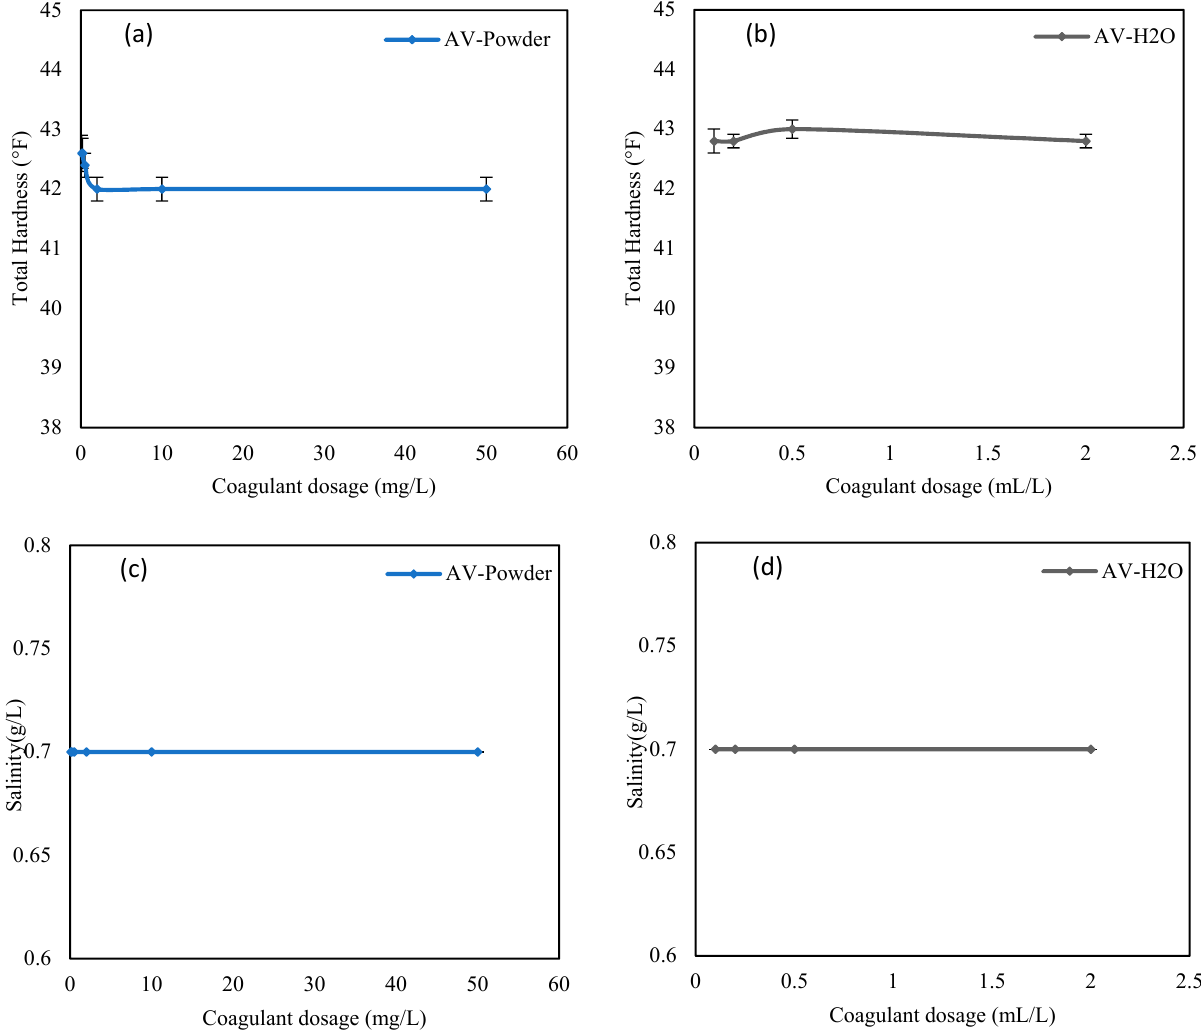
Figure 7. Effect of bio-coagulant dosage on: ( a , b ) total hardness; ( c , d ) salinity by using AV-Powder and AV-H 2 O.